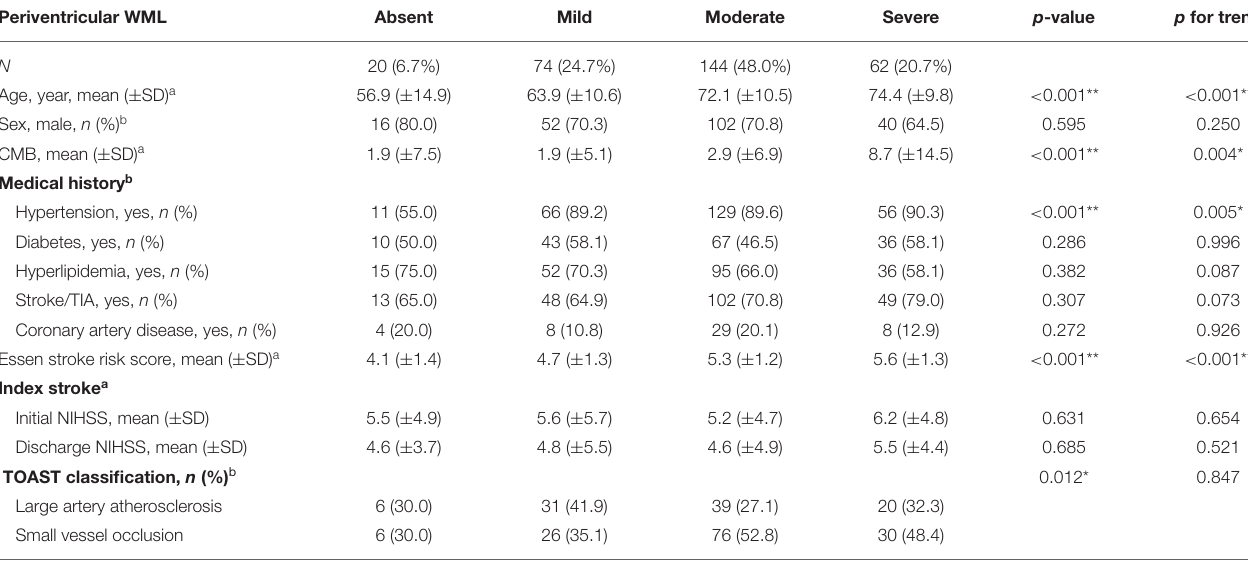
TABLE 2 | Relationship between periventricular white matter lesions and characteristics of stroke patients with aspirin treatment failure. Periventricular WML Absent Mild Moderate Severe p -value p for trend